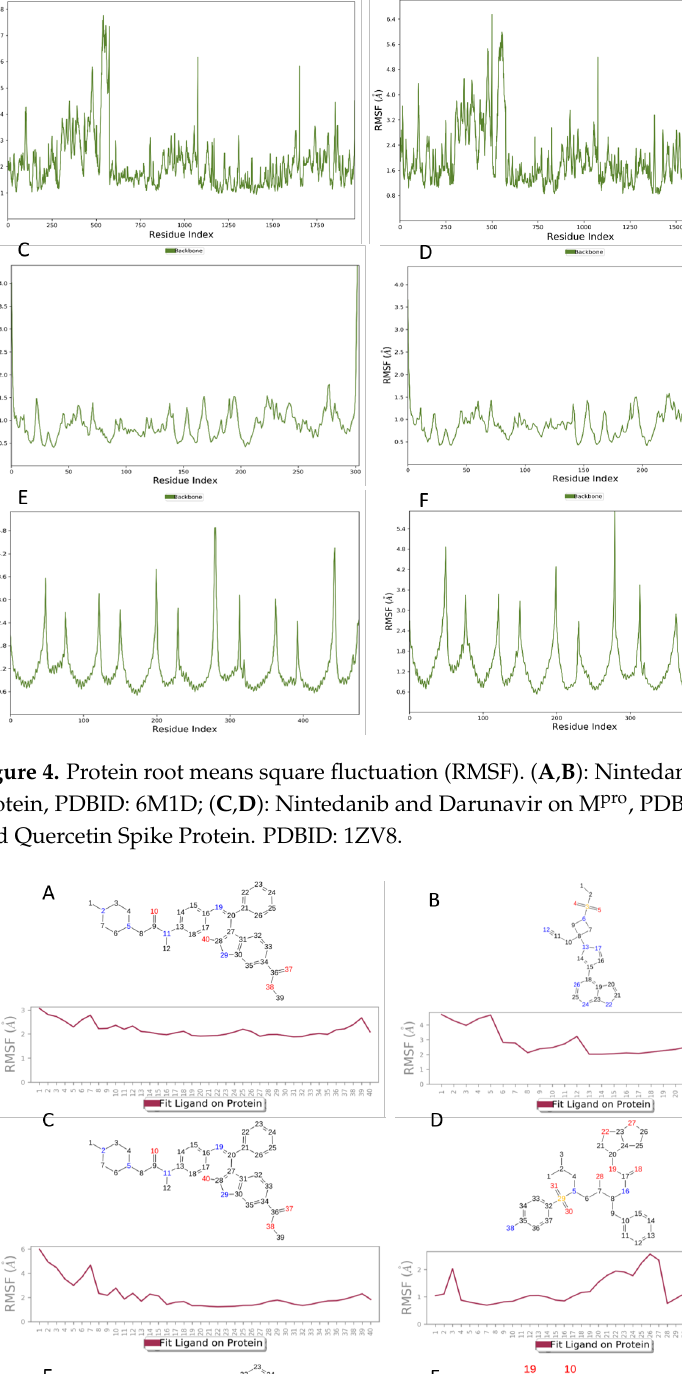
Figure 6. Ligand 3D interactions. ( A , B ): Nintedanib and Baricitinib on ACE2 Protein, PDBID: 6M1D; ( C , D ): Nintedanib and Darunavir on M pro , PDBID: 5R82; ( E ): Nintedanib; ( F ): Quercetin on Spike Protein. PDBID: 1ZV8.